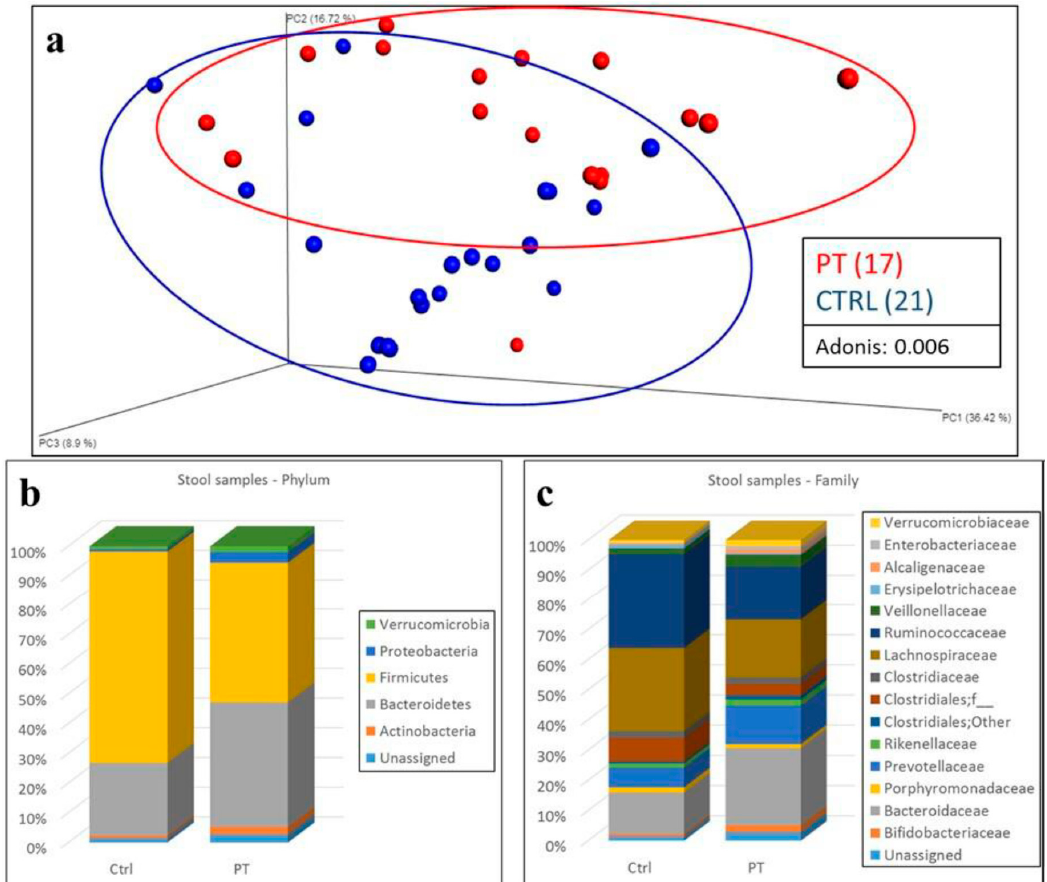
Figure 1. Analysis of fecal samples. ( a ) Beta diversity analysis of fecal samples with respect to subject status: Lynch syndrome patients = PT (red); control subjects = CTRL (blue). Weighted UniFrac distance metric and principal component analysis were used to perform beta-diversity analysis. A cluster can be observed between the two groups, confirmed by Adonis analysis ( p : 0.006). Statistical analysis: Adonis. Statistical significance: p < 0.05. ( b , c ) Taxonomic composition of stool samples from Lynch syndrome patients (PT) and control subjects (CTRL) at phylum ( b ) and family ( c ) levels. Relative bacterial abundances are expressed as average percentage. * Statistical significance: p < 0.05.